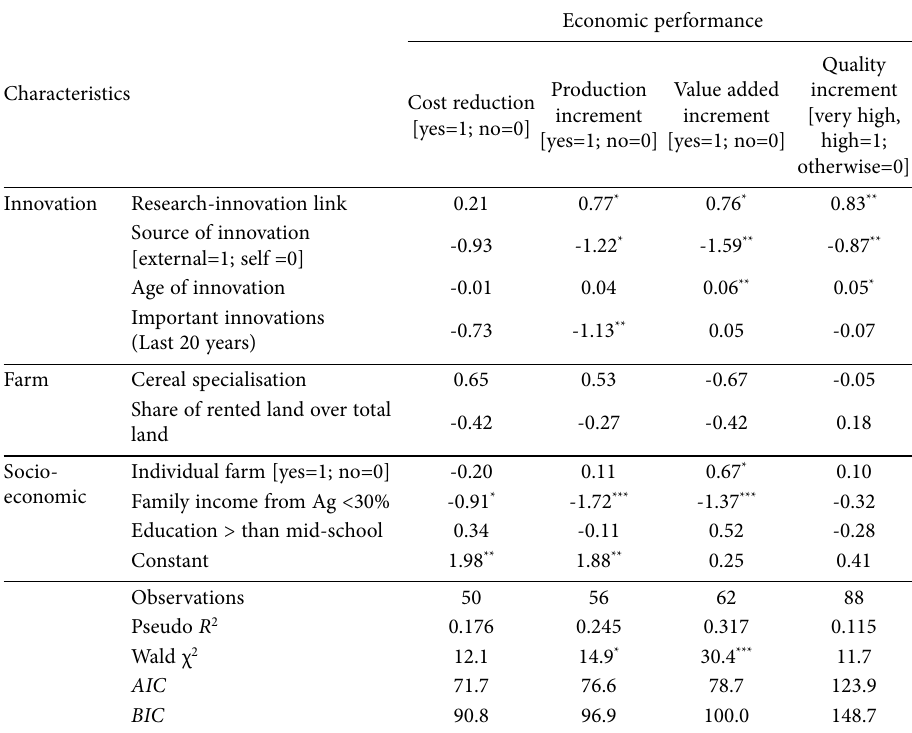
Table 8. Probit performance